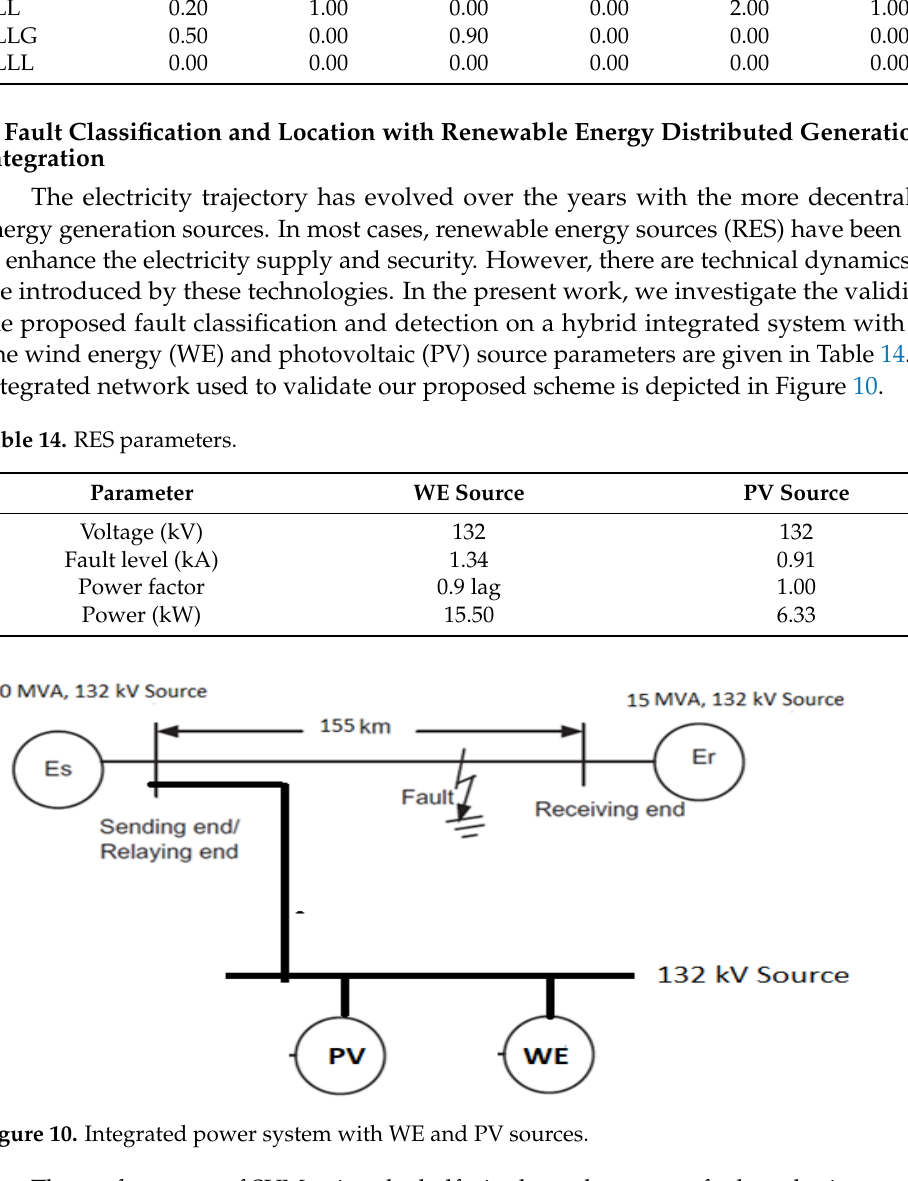
Table 15. SVM classification from half a cycle post-fault with PV and WE sources.